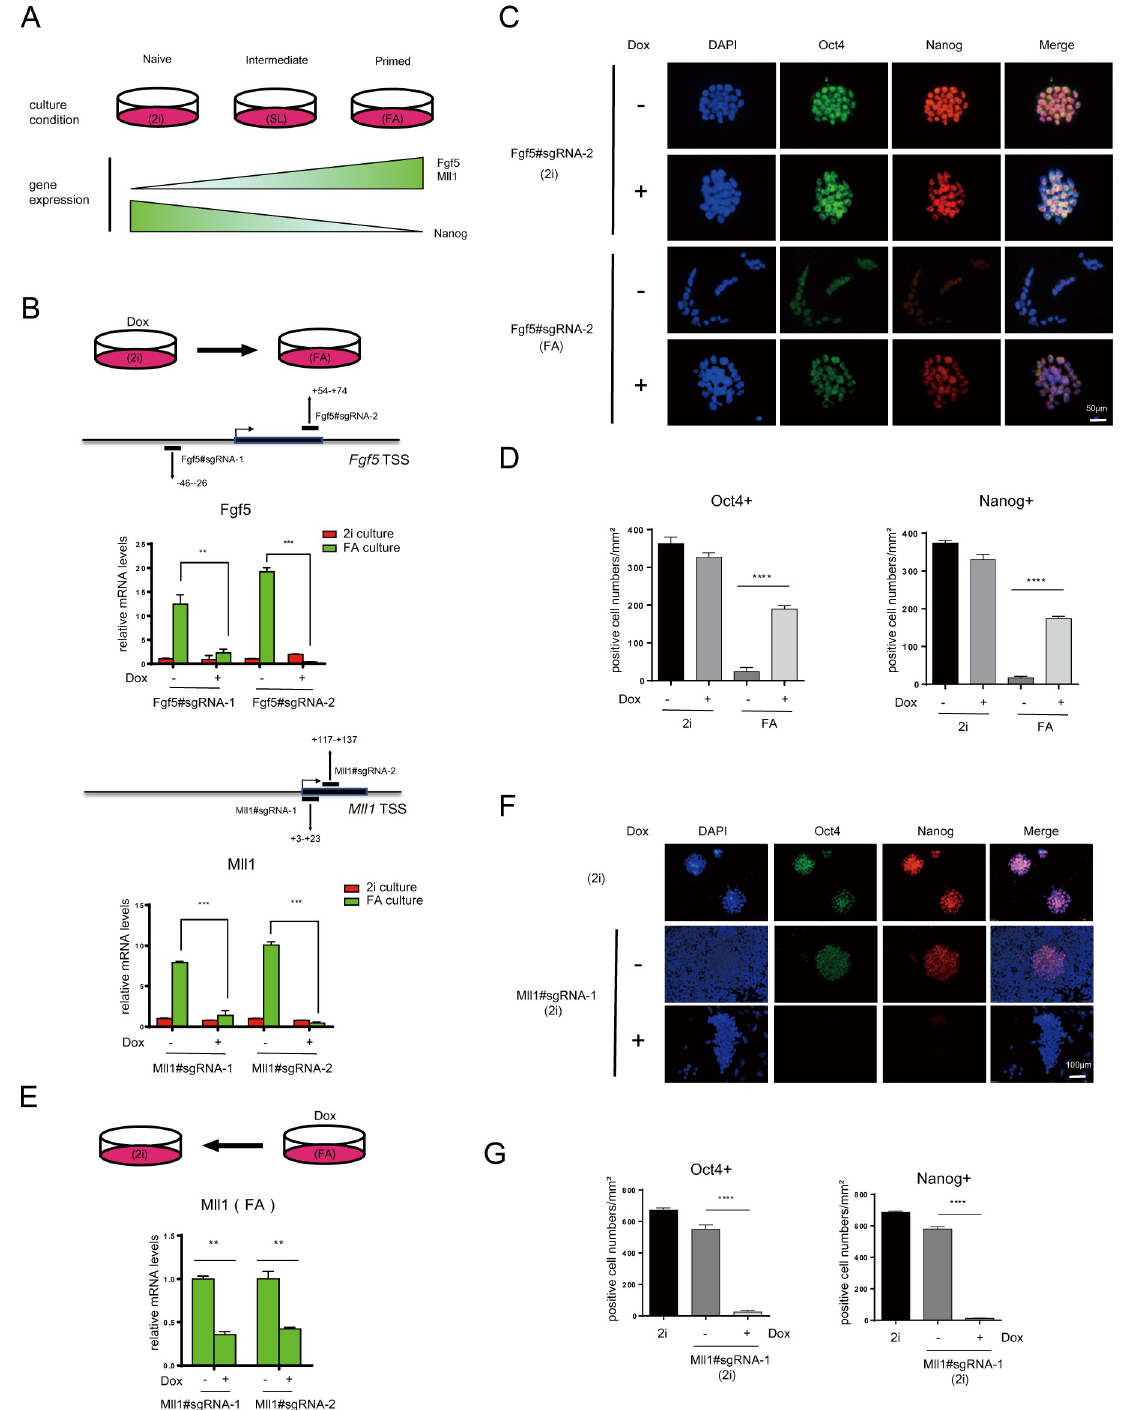
Fig 3. Induced dCas9-KRAB at promoters is sufficient to maintain gene inactivation. (A) Schematic diagram shows the dynamics of different states and marker gene expression of pluripotent stem cells cultured in different conditions. (B) RT-qPCR analysis of Fgf5 and Mll1 mRNA levels of iKRAB cells containing designated sgRNAs (with or without Dox) upon culture condition switch from 2i to FA. The binding location of each sgRNA is indicated relative to the TSS of the Fgf5 or Mll1 locus. (C) Representative IF staining of Oct4 and Nanog in iKRAB cells containing Klf5#sgRNA-2 treated with or without Dox in 2i condition or 2i switch to FA condition. The scale bar represents 100 μ m. (D, G) The relative Oct4 and Nanog-positive cell numbers (normalized by DAPI+ cell numbers) are compared. (E) RT-qPCR analysis of Mll1 mRNA levels of iKRAB cells containing the same sgRNAs as (C) (with or without Dox) in FA condition. (F)